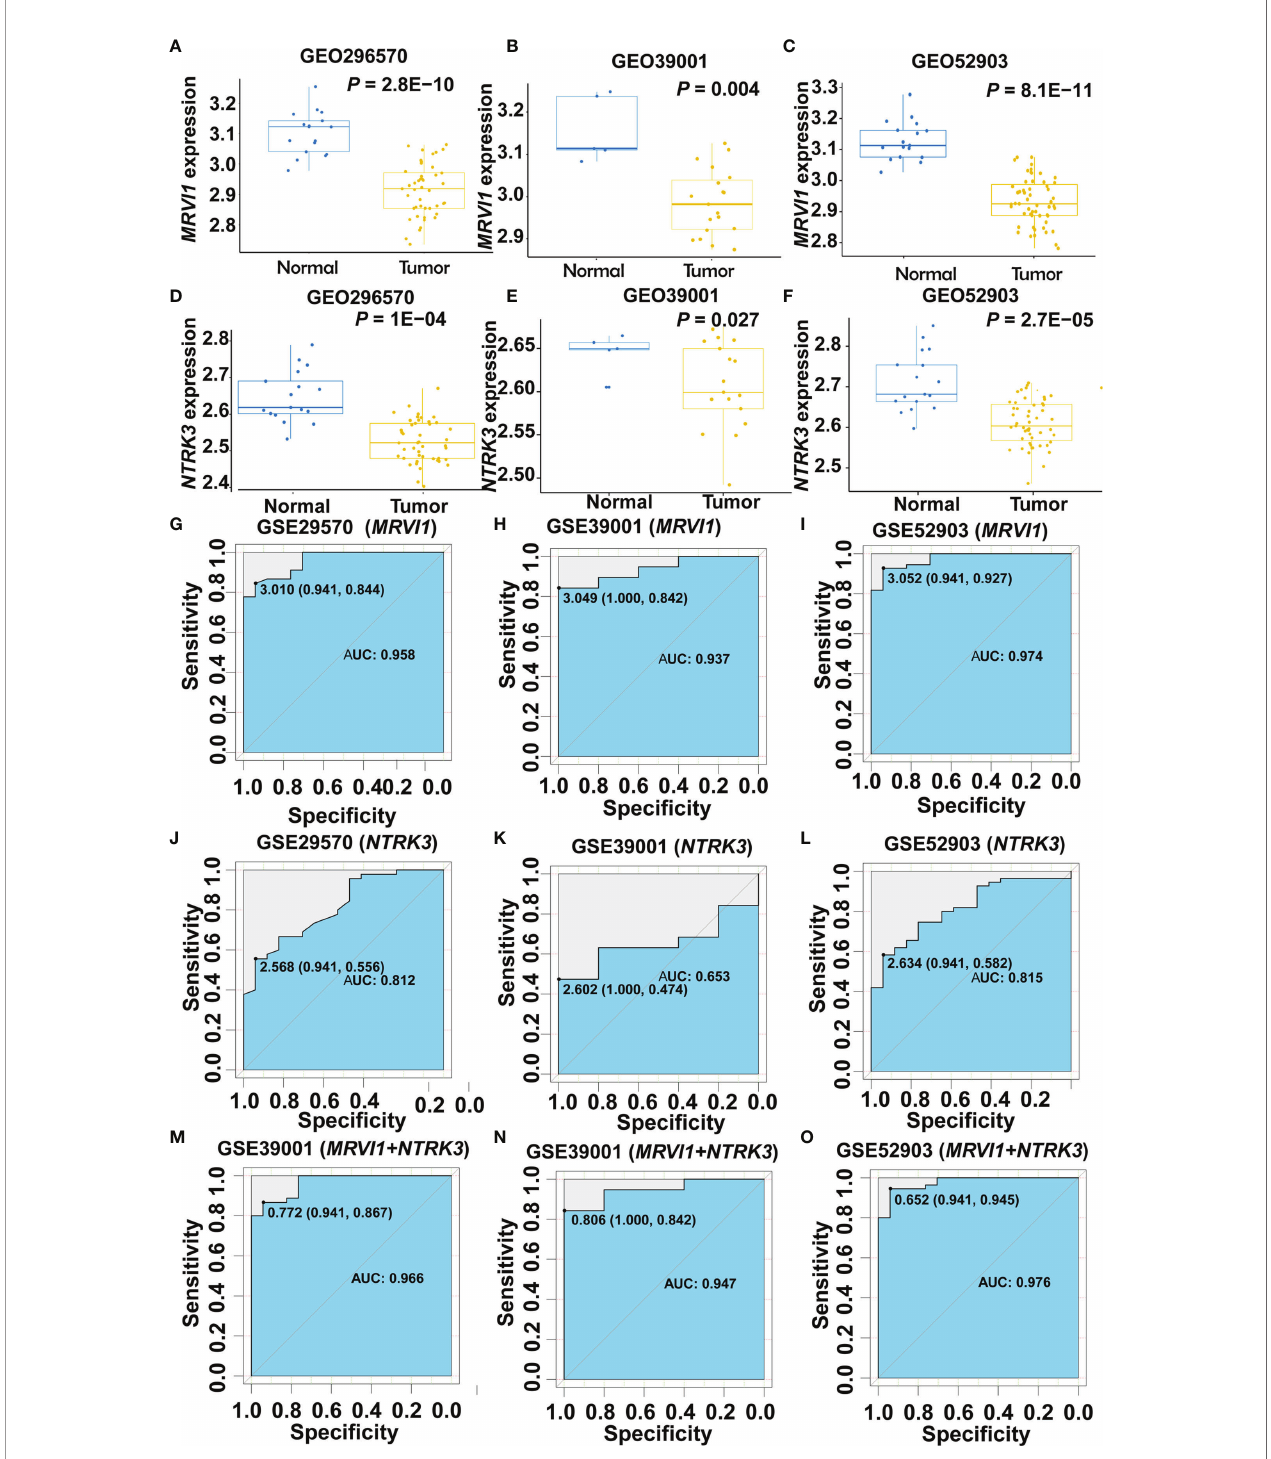
FIGURE 6 | Con fi rmed expression levels and ROC curve analyses for the prediction of cervical cancer. (A – F) Boxplots of gene expression levels in three GEO databases for MRVI1 and NTKR3 . The left y-axis shows the mRNA expression levels for MRVI1 or NTRK3 . The x-axis represents the two groups (normal tissue and cervical tumor). Each panel represents a different GEO database (GSE29570, GSE39001, and GSE52903). ROC curve of MRVI1 (G – I) , NTRK1 (J – L) , and combined expression (M – O) for distinguishing between cervical cancer and non-tumor tissues in individual GEO datasets. AUC, the area under the ROC curve; GEO, Gene Expression Omnibus; ROC, receiver operating